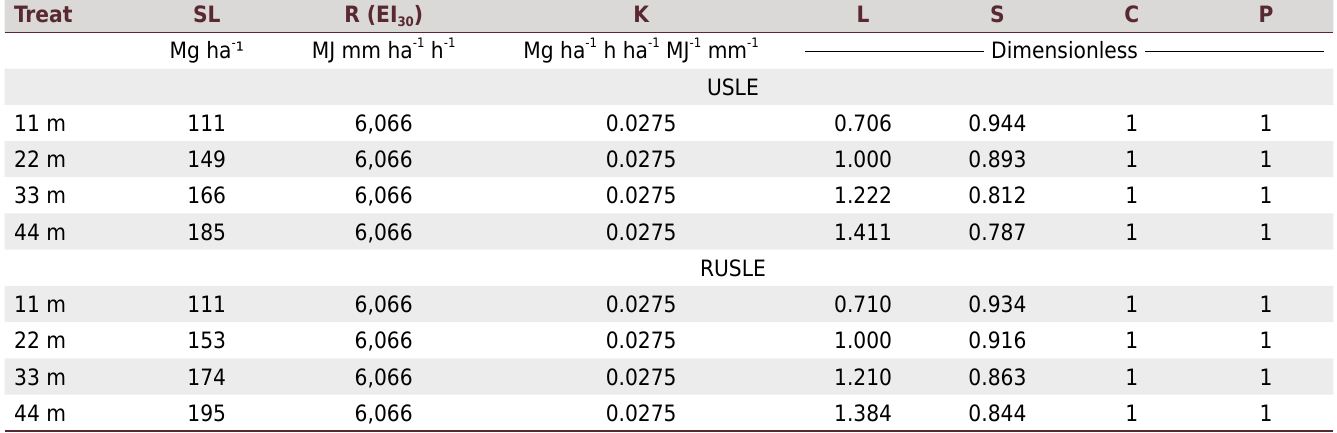
Table 3. Values of SL estimated by the USLE and RUSLE, R factor (EI 30 ), K factor, L factor, S factor, C factor, and P factor in the different treatments (Treat) (average of replications)